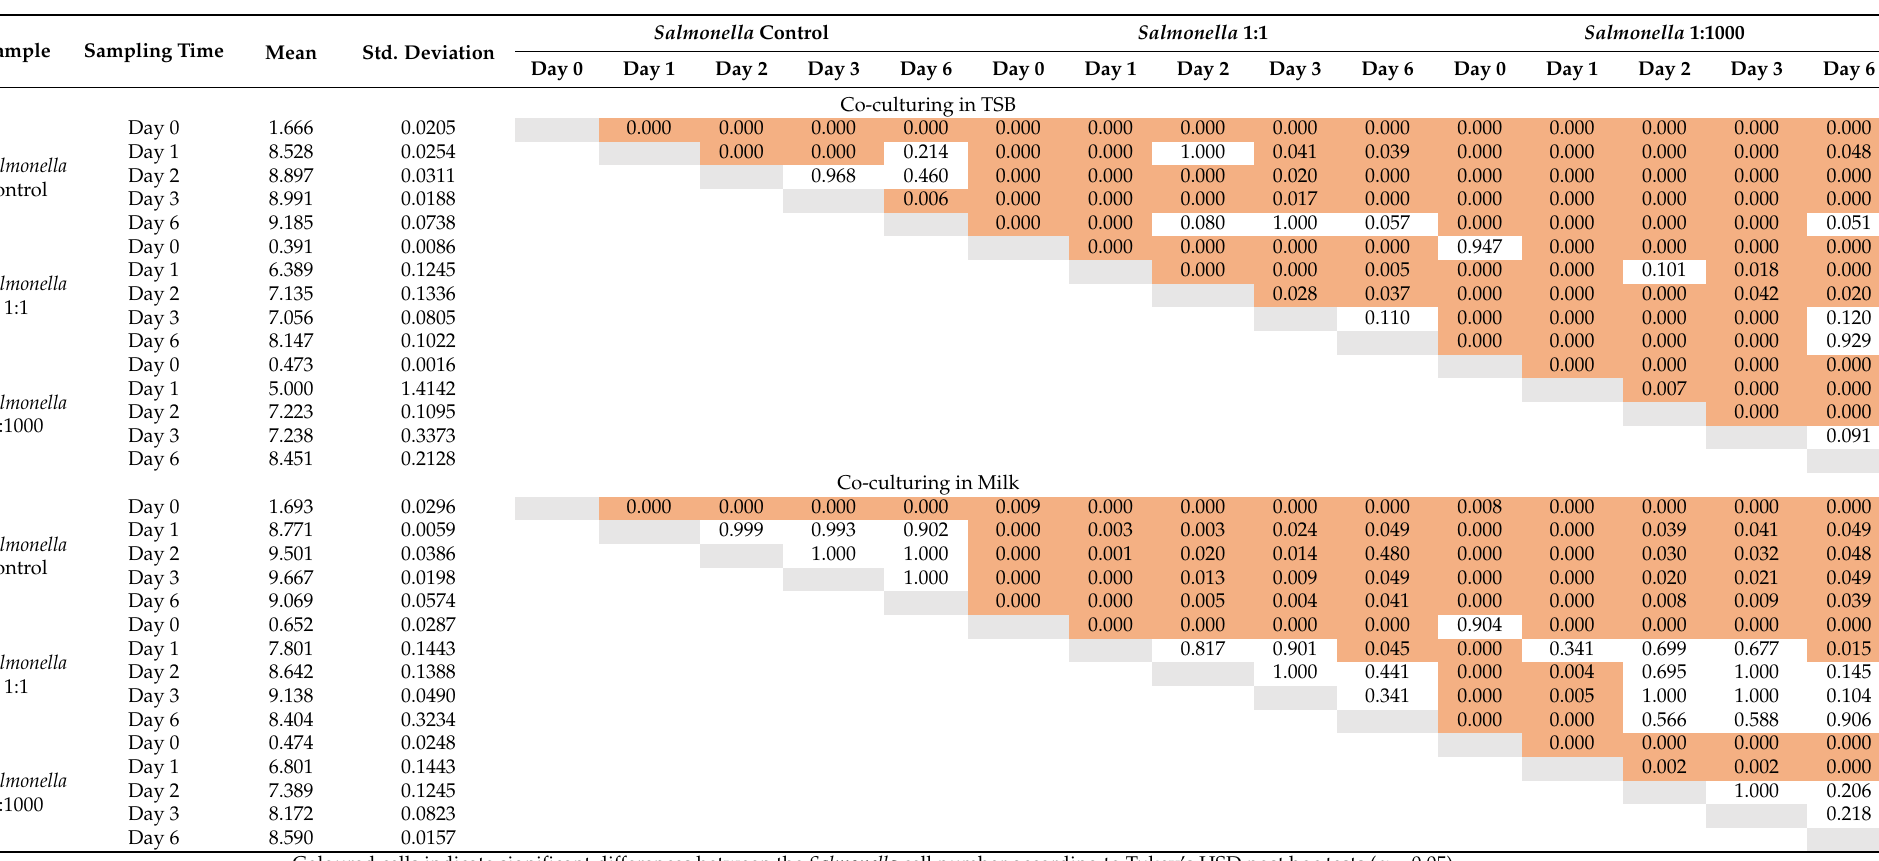
Table 5. Results of statistical analysis of co-culturing in the case of Sa. enterica and S. marcescens CSM-RMT-1 in TSB and milk. Significance is expressed by p